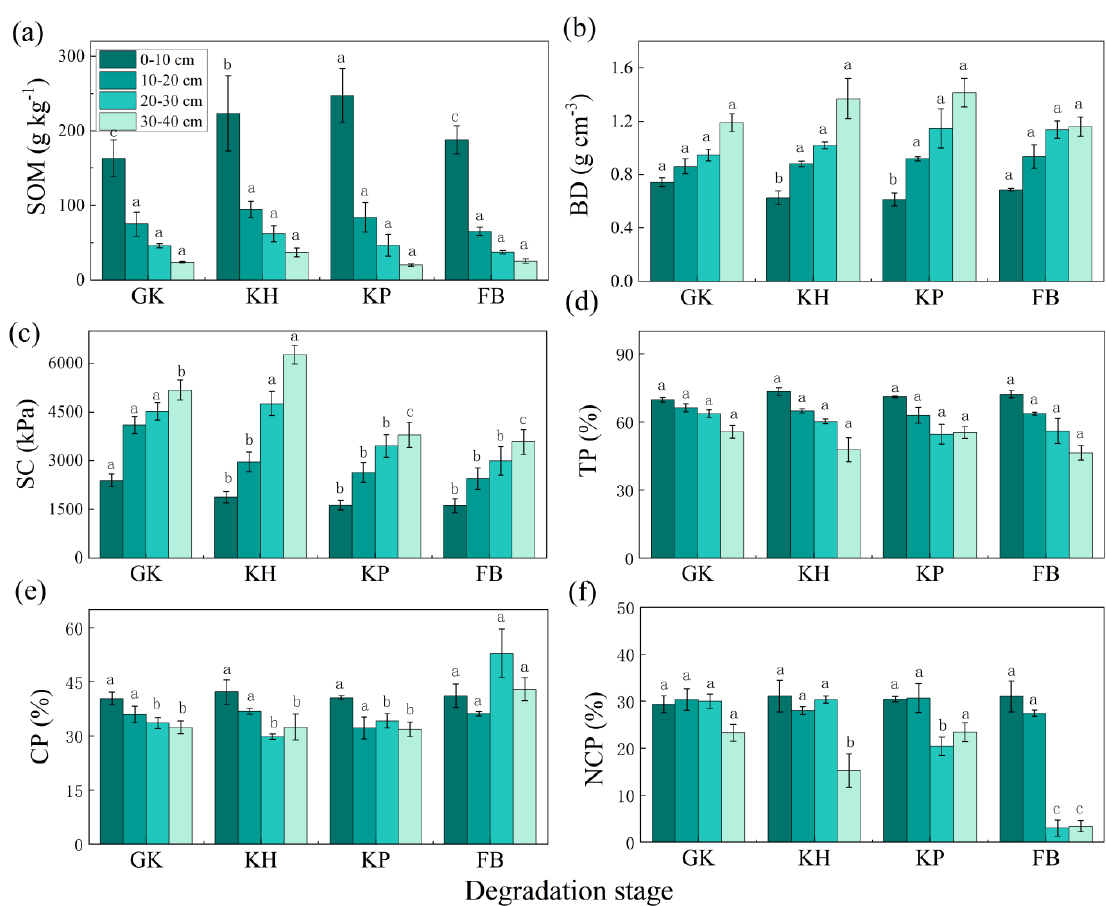
Figure 2. Soil properties of multi-stable alpine meadows at different depths: ( a ) soil organic matter (SOM); ( b ) soil bulk density (BD); ( c ) soil compaction (SC); ( d ) soil total porosity (TP); ( e ) soil capillary porosity (CP); ( f ) noncapillary porosity (NCP). The error bar represents the standard error. Letters above bars mean a statistical significance was detected using ANOVA and Duncan’s post hoc test ( α = 0.05) for each depth across different types of communities. GK, Gramineae grass – Kobresia humilis community; KH, K. humilis community; KP, K. pygmaea community; FB, Forbs-Black